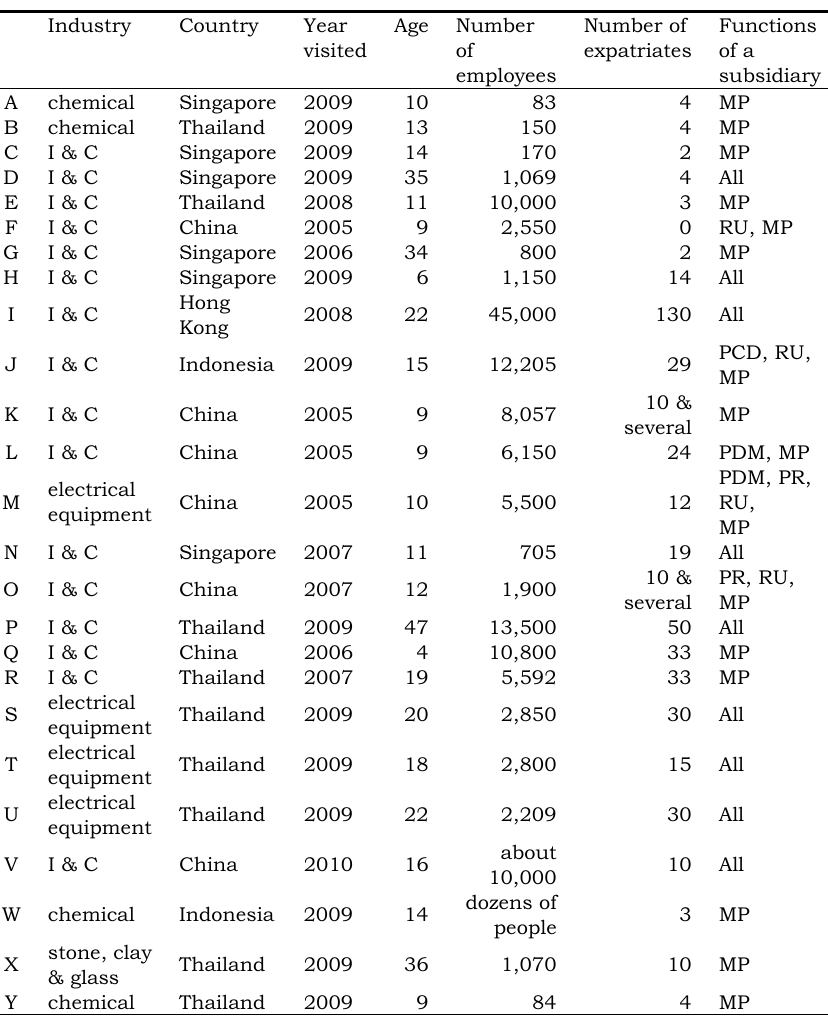
Table 2. Profiles of sample